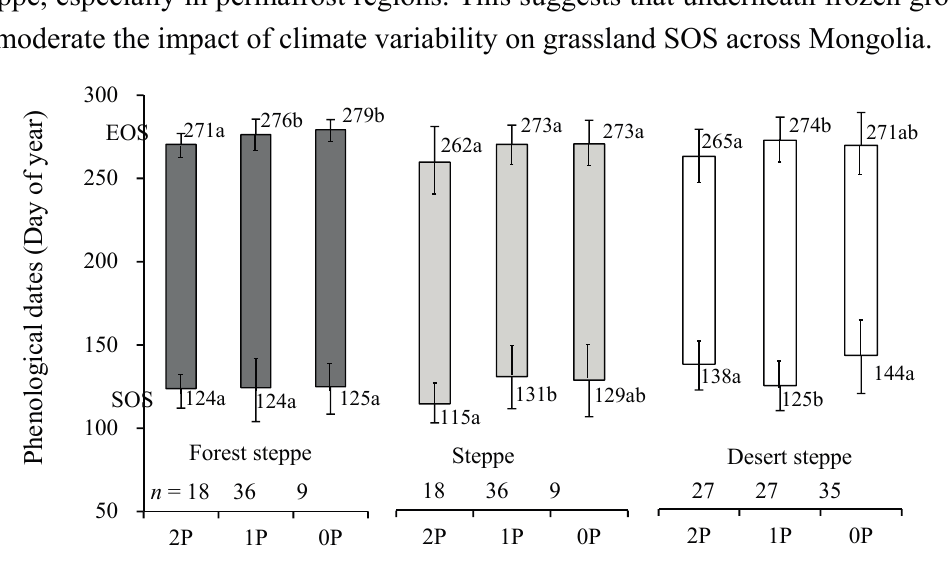
Figure 3. Means and standard deviations of SOS and EOS for three steppe types with three frozen ground types in Mongolia. The n is the number of phenological records for SOS and EOS. The 0P, 1P, and 2P represent seasonal frozen ground, sporadic permafrost, and permafrost, respectively. The bar is the standard deviation. For each grassland type, the same letters following mean values indicate no significant difference in SOS and EOS between three permafrost types at the 5% significance level,